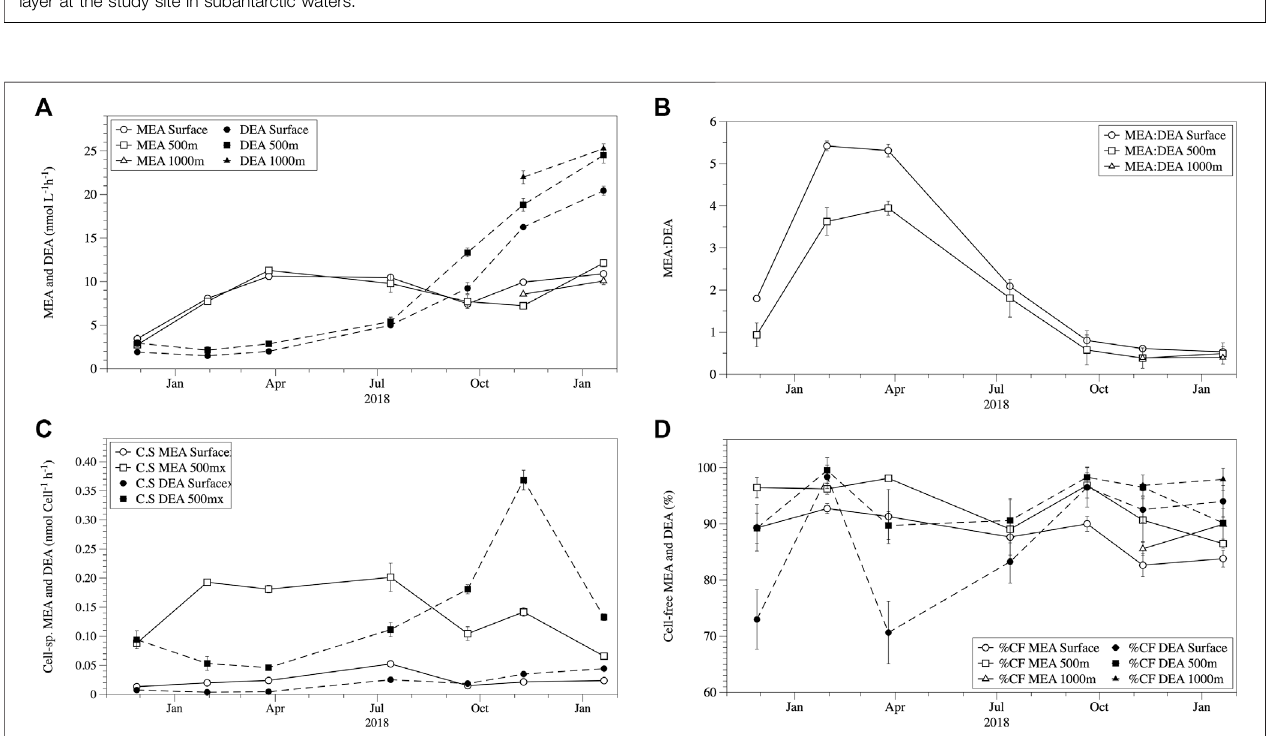
FIGURE1| Seasonalvariabilityintemperature,phosphate,and nitrate (A) ,and chlorophyll- a and mean( ± SE)bacterial abundance (B) intheepi-and mesopelagic layer at the study site in subantarctic waters.